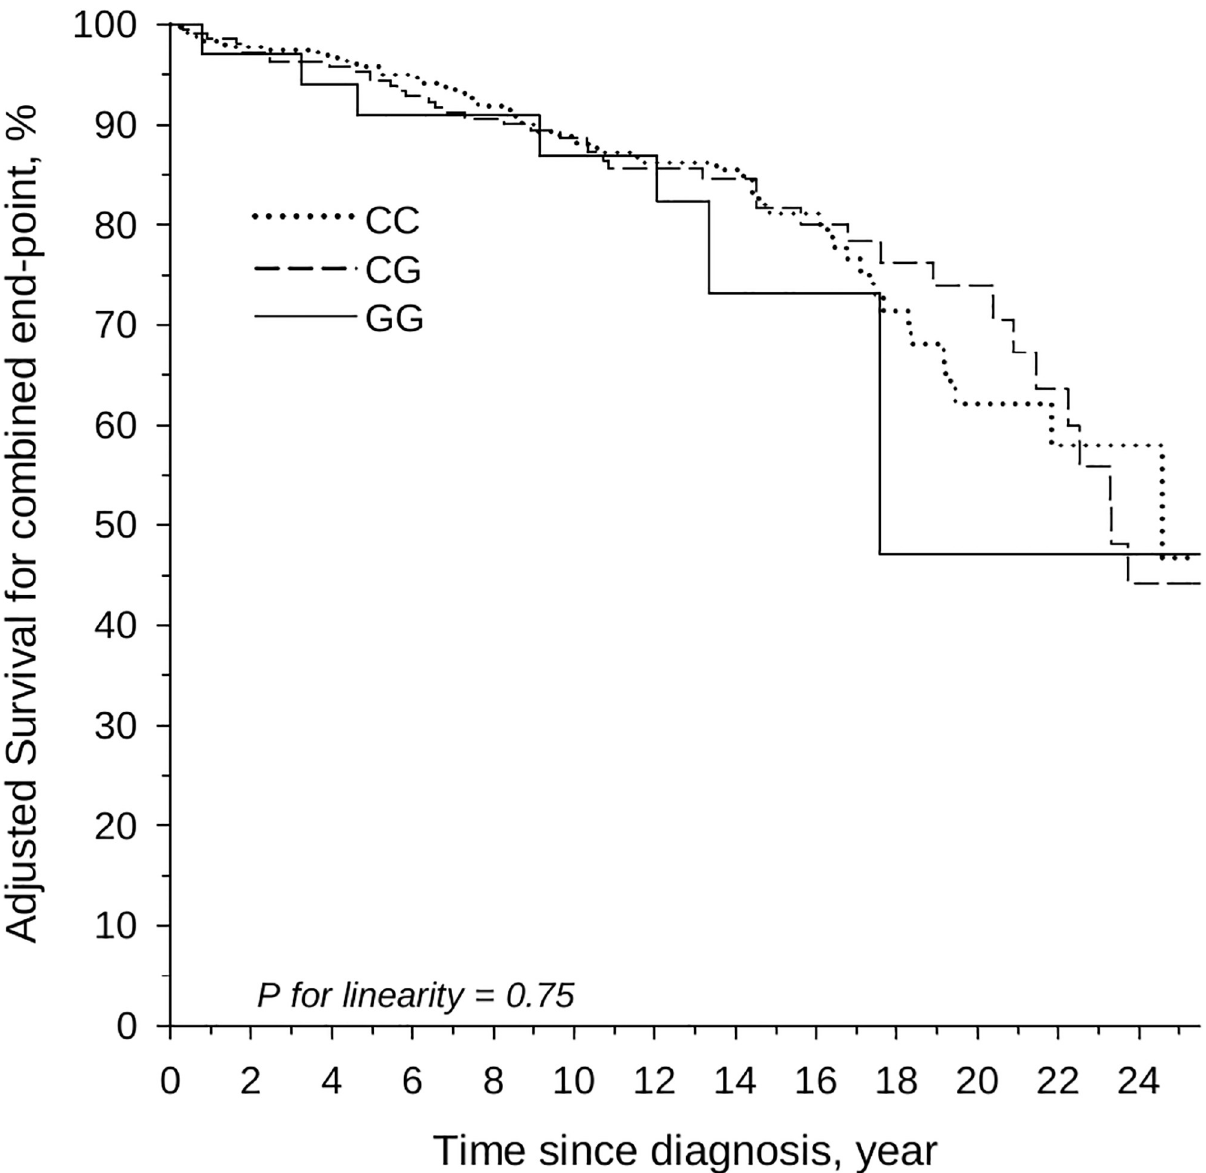
Fig 2. Proportion of patients who did not reach the composite end point (CCA, liver transplantation, and deaths) according to the PNPLA3 allele frequency; adjusted for sex and age at PSC diagnosis.